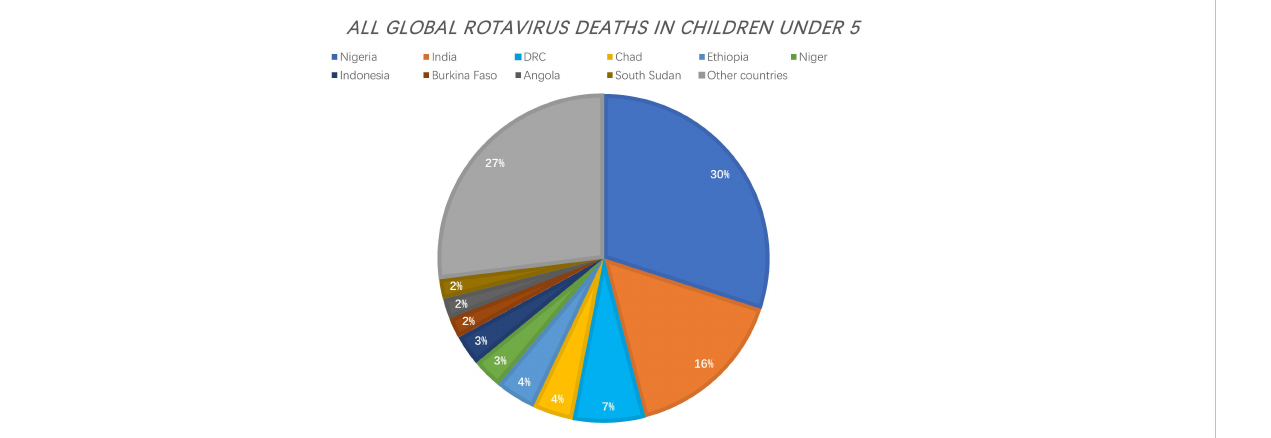
FIGURE 1 The Countries with the Greatest Number of Rotavirus Deaths as a Proportion of All Global Rotavirus Deaths in Children under 5. 53% of rotavirus- associated deaths worldwide occurred in three countries (Nigeria, India, Democratic Republic of Congo). [https://preventrotavirus.org/rotavirus-